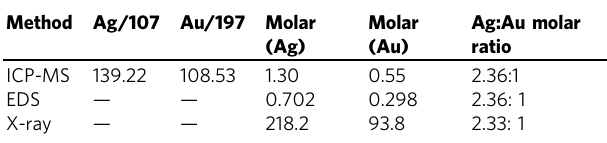
(AuAg) 267 is surrounded by six octahedral-arranged (AuAg) 45 nanoclusters while each (AuAg) 45 is neighbored by six (AuAg) 267 nanoparticles arranged in a trigonal prismatic fashion. The